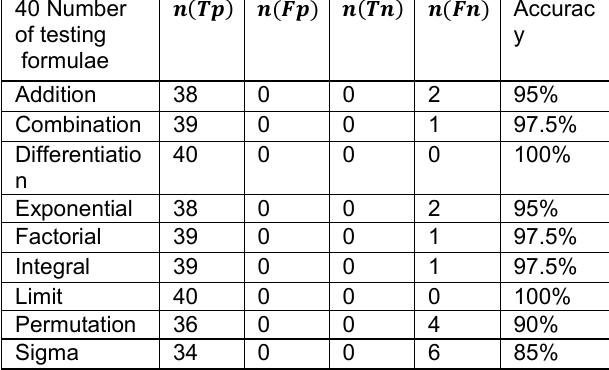
Table 20. The above tabulated value represents overall Accuracy Measure with Tensorflow from a document of 40